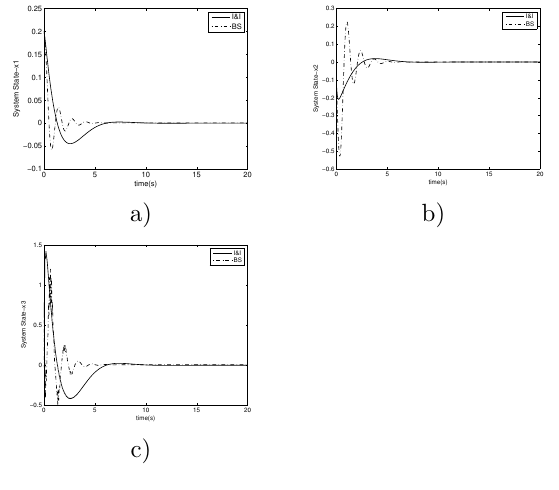
Figure 2. Dynamic response of a) x 1 , b) x 2 , c) x 3 .